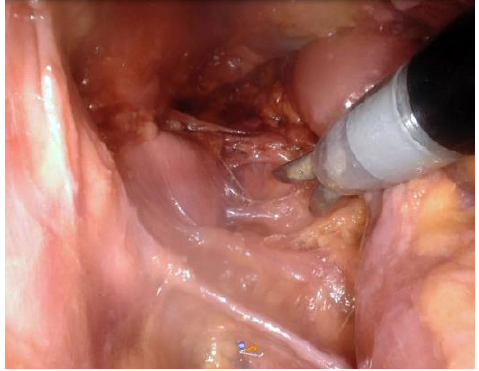
Figure 7. Da Vinci SP view on the aortal branches in the lower mediastinum.